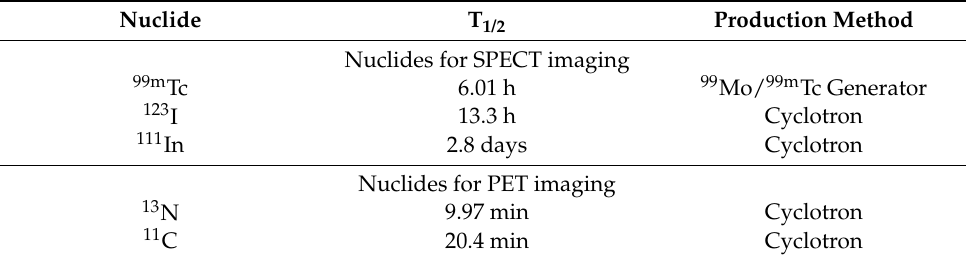
Table 1. Nuclides used in PET and SPECT imaging.